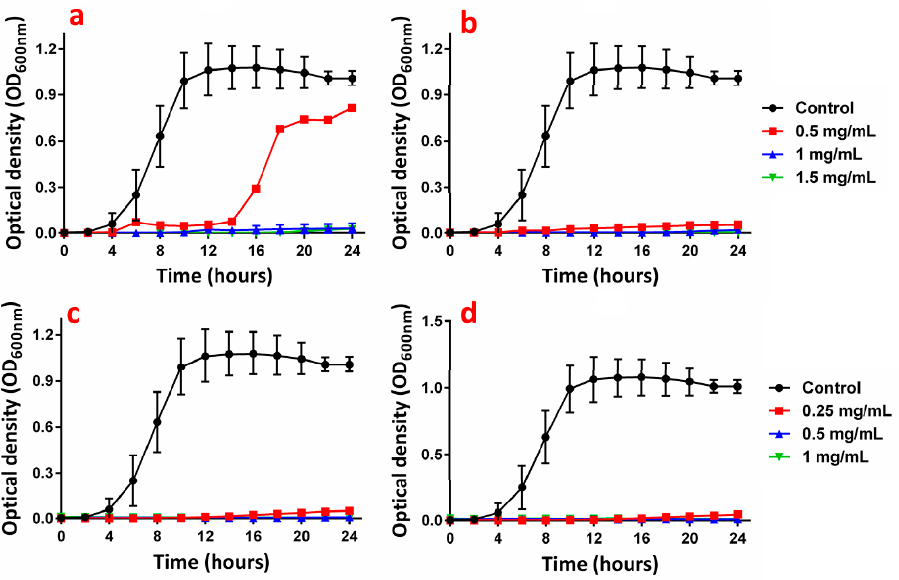
Figure 18. Growth curves of the nanocomposites A with the ratios ( 1 ) ( a ), ( 2 ) ( b ), ( 3 ) ( c ), and ( 4 ) ( d ) at various concentrations against S. aureus .